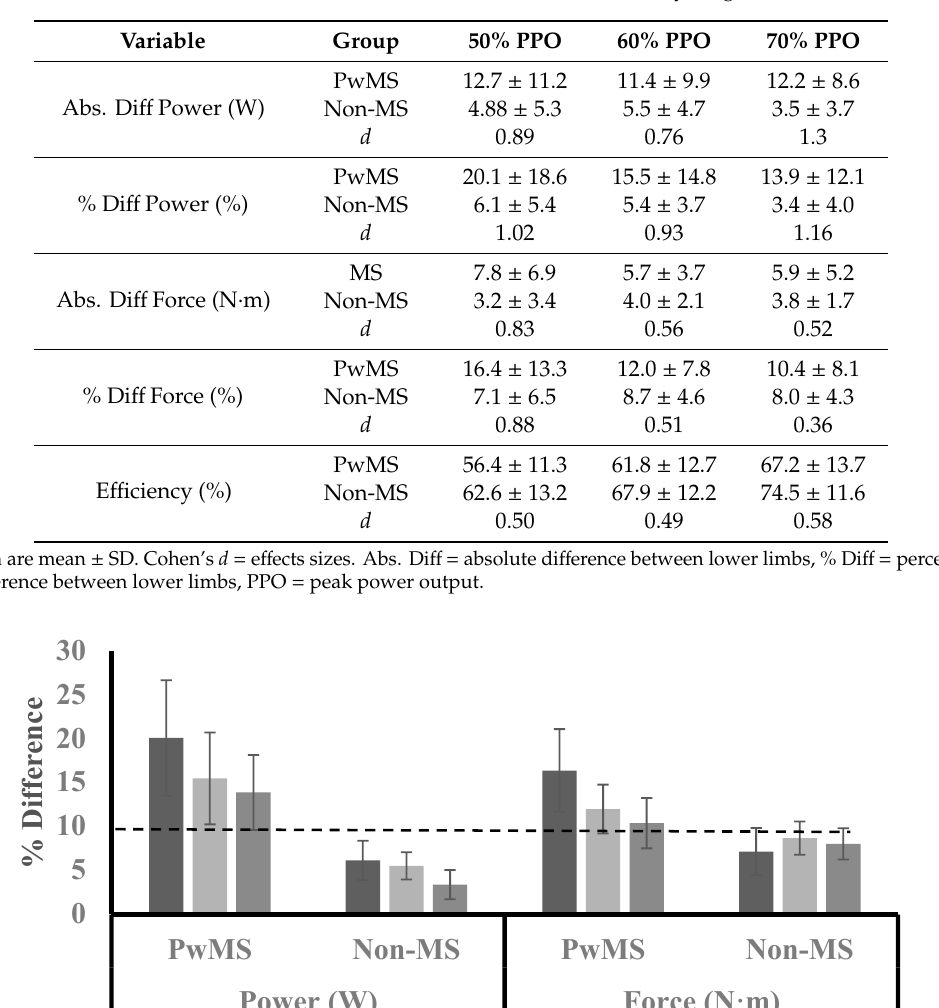
Table 4. Variables from the submaximal incremental cycling test.